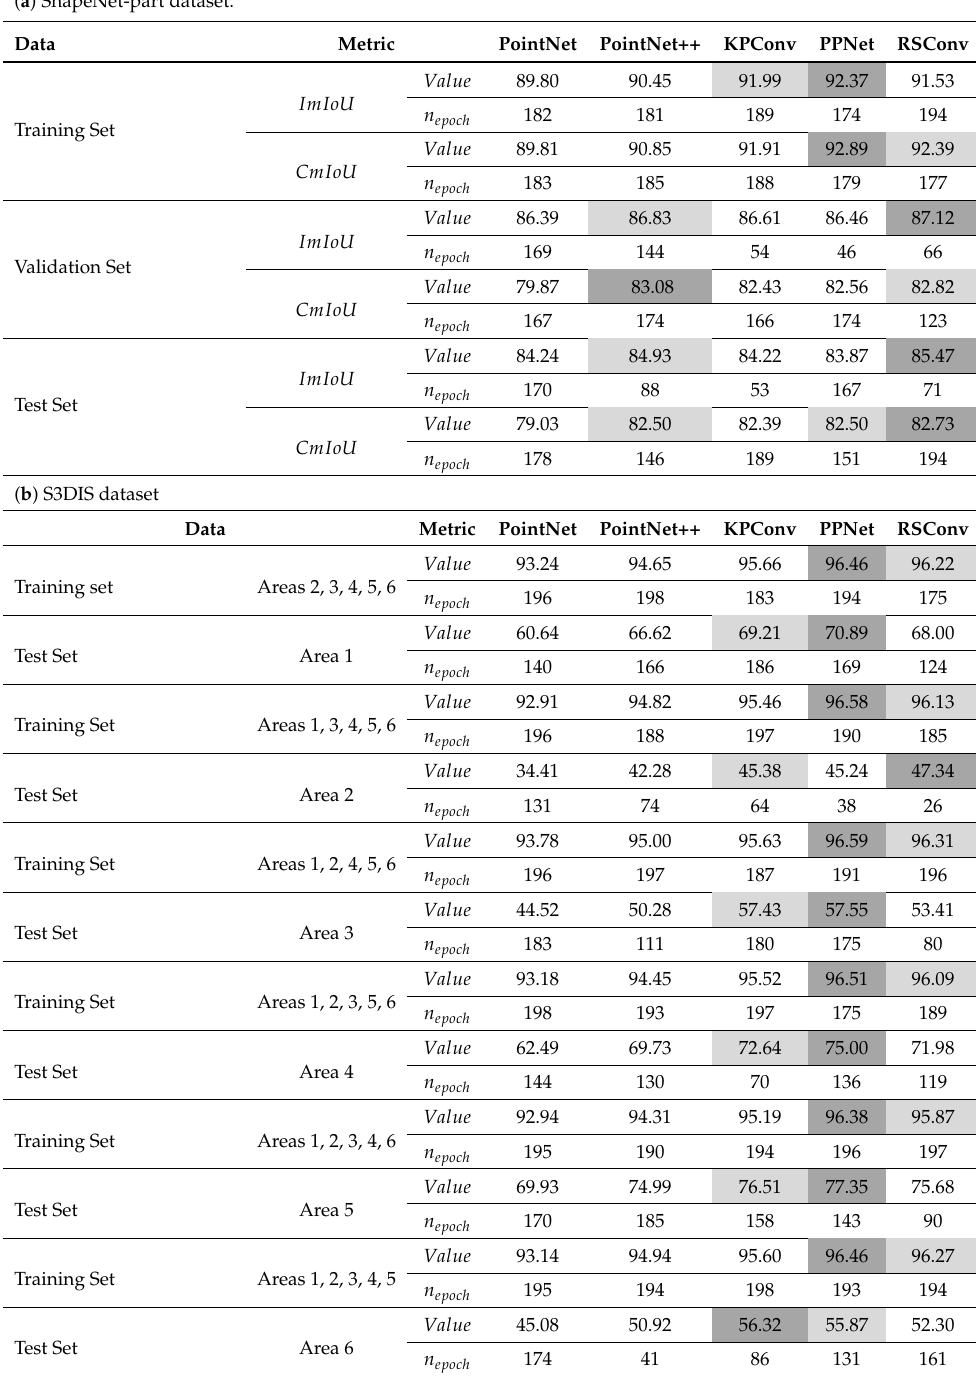
Table 4. Comparison of deep learning models in terms of segmentation accuracy evaluation of the learning process in 200 epochs. In table ( a ), we display ImIoU and CmIoU metrics (best-achieved score) on the ShapeNet-part dataset and, similarly, in the table ( b ) we show the mIoU (or alternatively the ImIoU ) metric on all the Areas of S3DIS dataset. We use dark grey and light grey cell colors to denote the best and the second best score per metric